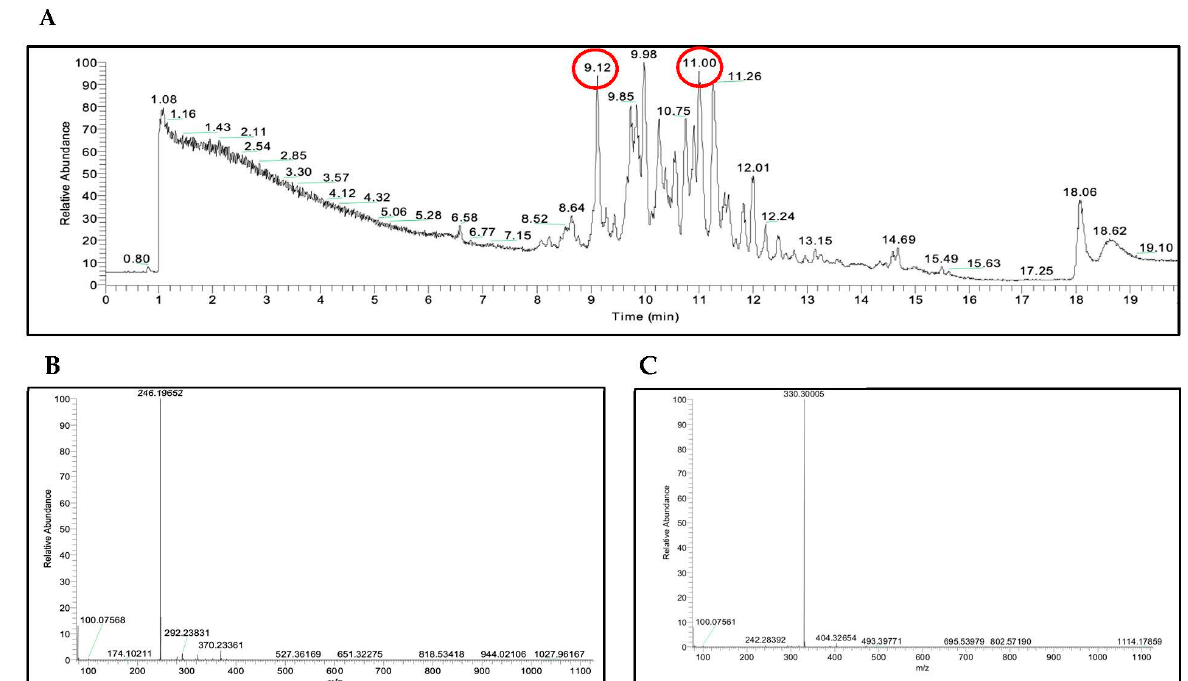
Figure 7. UHPLC-HRMS analysis of sub-fraction R4. ( A ) UHPLC chromatogram. Peaks analyzed by HRMS are marked with a red circle. ( B ) HRMS of the chromatographic peak from the sub-fraction R4 eluted with a retention time of 9.12, showing an [M + H] + ion adduct that matches the molecular formula of C 15 H 23 N 3 for mirabilin B. ( C ) HRMS of the chromatographic peak from the sub-fraction R4 eluted with a retention time of 11.0 with an [M + H] + ion adduct that matches the molecular formula of C 19 H 39 NO 3 for penaresidin B.